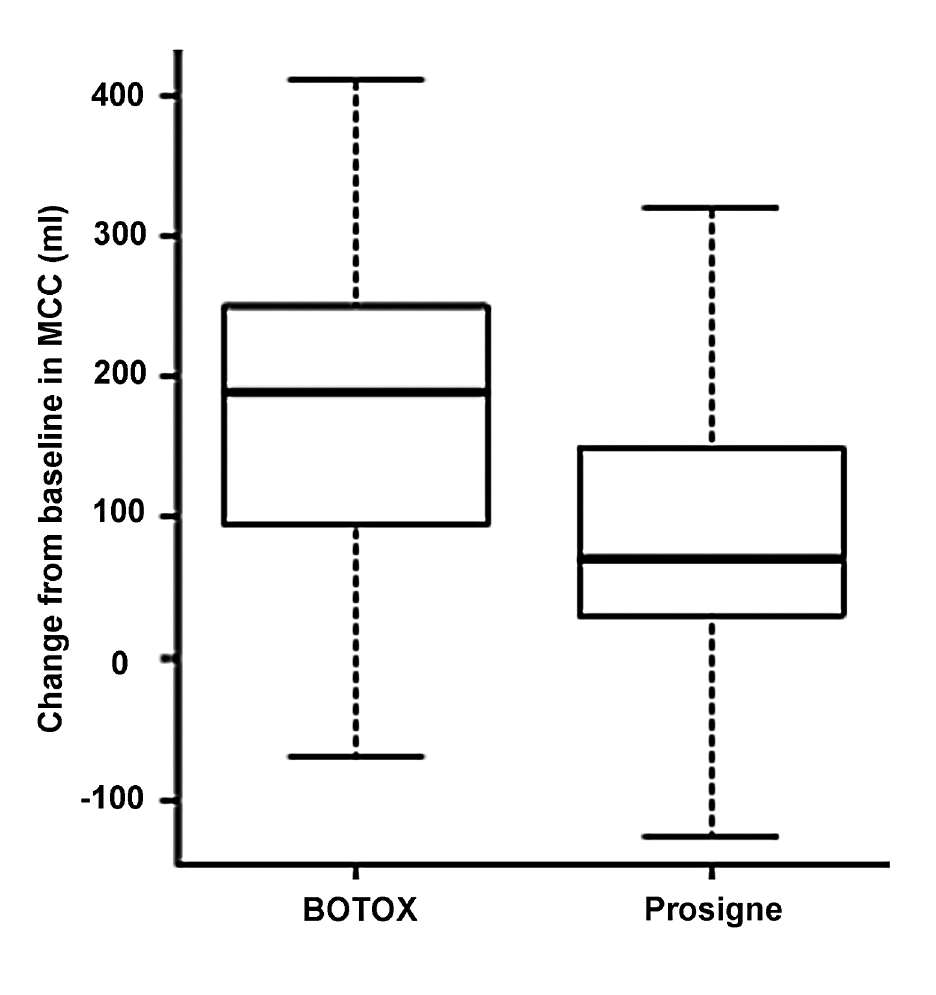
Figure 1 – Box-plot analysis of change from baseline in maximum cystometric capacity (MCC) at week 12, according to treatment